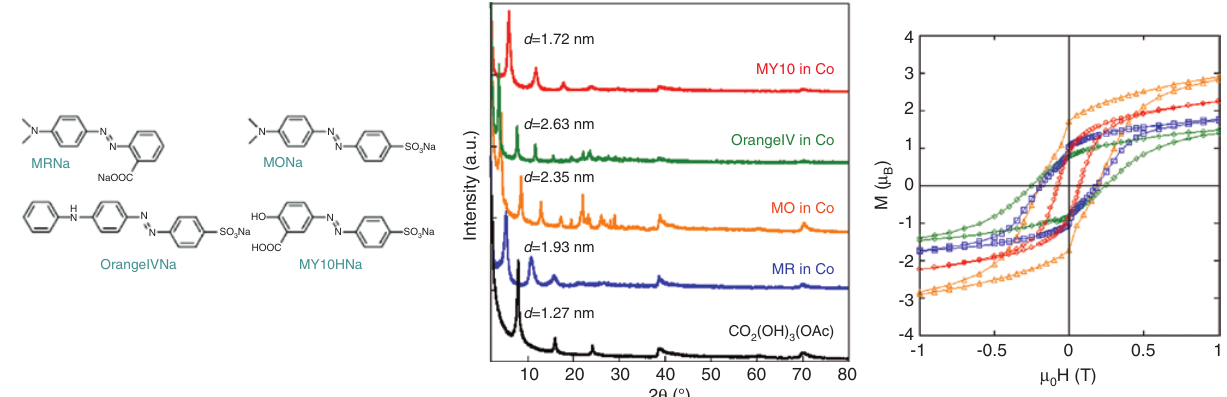
Figure 19: Azo dyes used for anion exchange reaction and X-ray powder diffraction patterns of the corresponding hybrid multilayer compounds. Right, magnetization cycles at 1.8 K of the Co(II) compounds MR@Co (blue), MO@Co (orange), OrangeIV@Co (green) and MY10@Co (red). Adapted with permission from [141]. Copyright 2009 Royal Society of Chemistry.